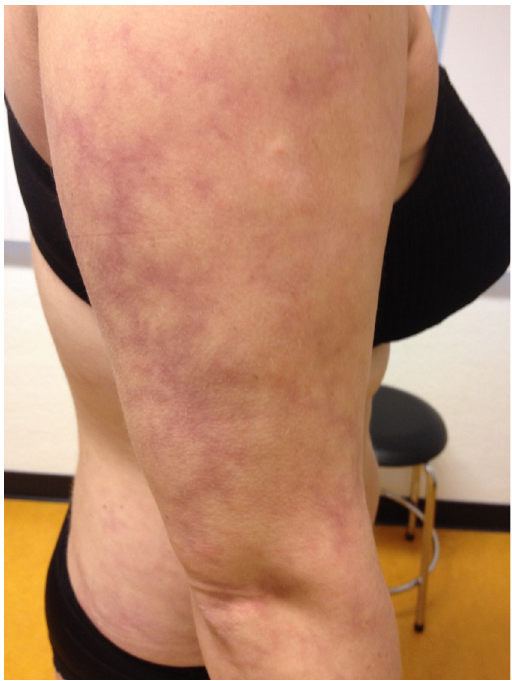
Fig 1. Livedo reticularis. This figure shows an example of a patient with Sneddon syndrome with livedo reticularis on the right arm. This patient also had livedo reticularis on the legs, trunk, buttocks and face.